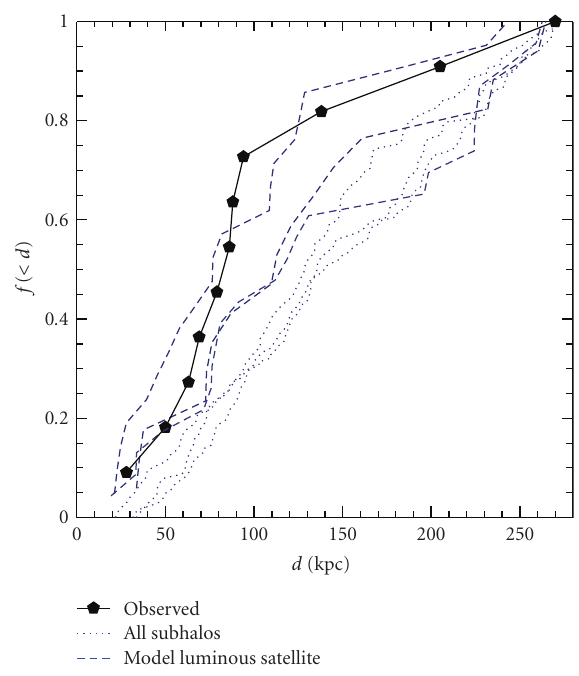
Figure 13: The cumulative radial distribution of the observed “classical” Milky Way satellites (solid points connected by the solid line) within 280kpc and satellites with similar luminosities and within the same distance from their host halo in the model of (4) (dashed lines). The figure also shows the cumulative distribution of all subhalos selected using their current V max (dotted